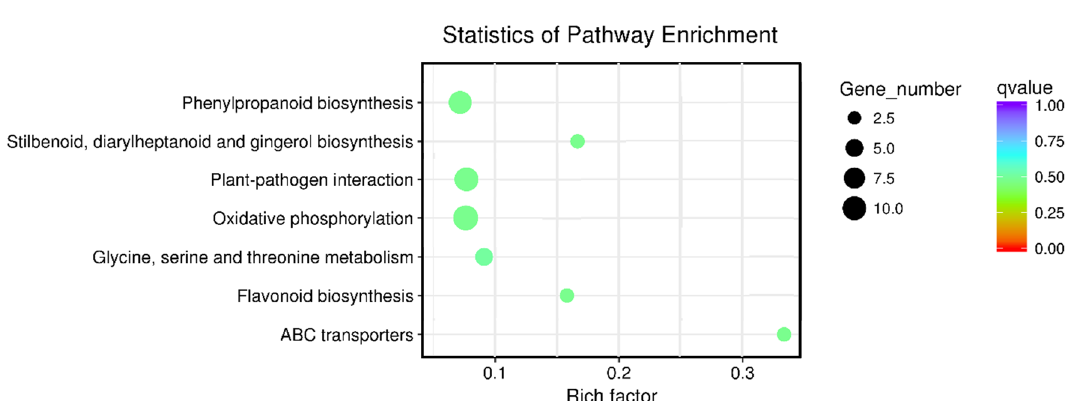
Figure 7. Kyoto Encyclopedia of Genes and Genomes pathway analysis of the DEGs in CK2 vs. MT2. The DEGs in CK2 vs. MT2 were enriched in 7 pathways. Genes corresponding to the categories “Oxidative phosphorylation”, “Plant–pathogen interaction”, “Phenylpropanoid biosynthesis”, “Glycine, serine and threonine metabolism”, “ABC transporters”, “Stilbenoid, diarylheptanoid and gingerol biosynthesis” and “Flavonoid biosynthesis” were